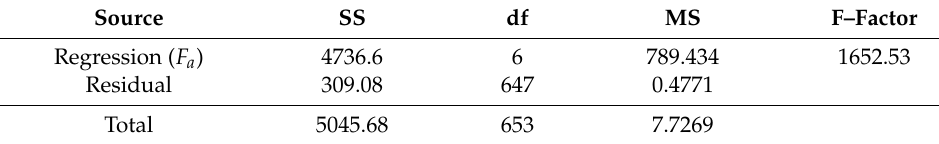
Table 7. Regression analysis for correlation of normal